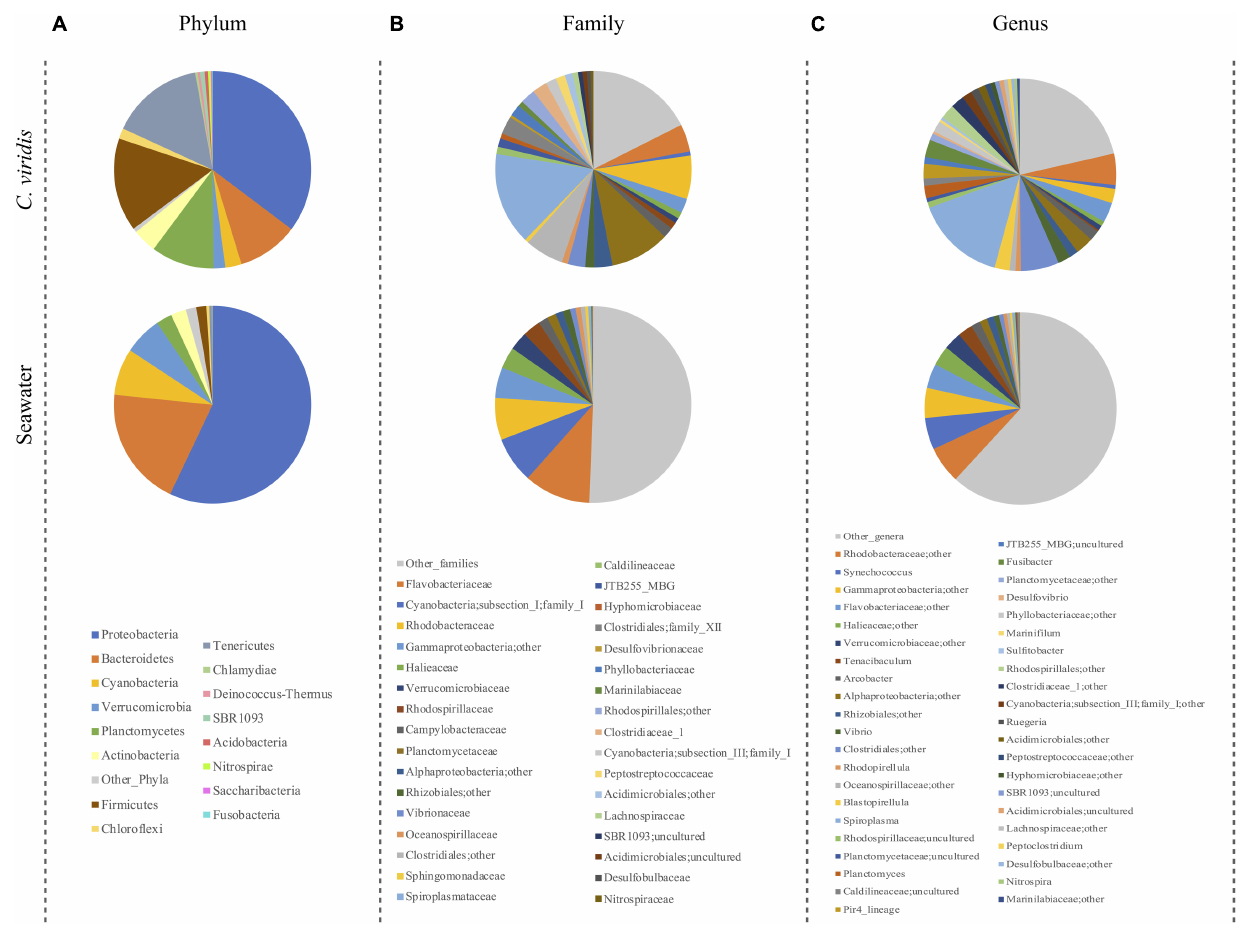
FIGURE 1 | Microbiota compositionof C. viridis and seawater. Pie charts summarizing the phylum (A) , family (B) and genus-level (C) microbiota composition of C. viridis and seawater. Only phyla with relative abundance > 0.5% in at least 10% of samples, and families and genera with relative abundance > 2% in at least 10% of samples are